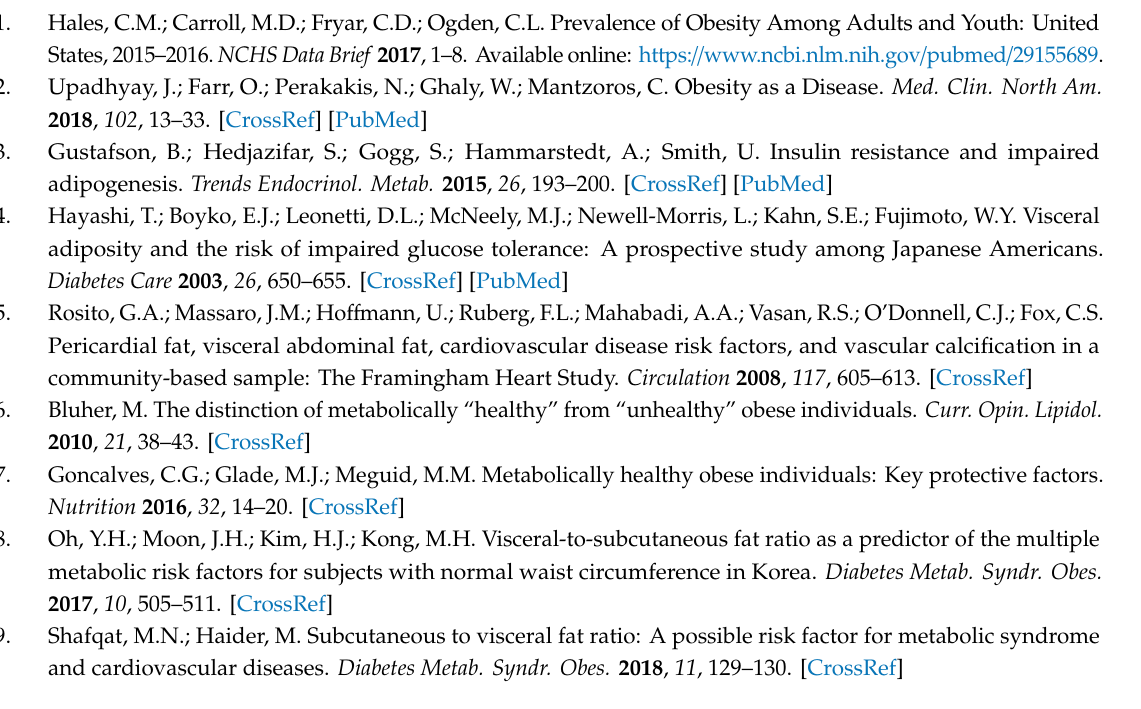
Figure S1: Analysis of housekeeping gene expression and adipose stem cell di ff erentiation. Average expression was calculated as genometric mean of three biological replicates, Figure S2: Bisulfite PCR analysis of NRG1 Type III CpG island. Bisulfite treatment causes cytosine (C, blue) to sequence as thymidine (T, green). Methylation is detected as retention of cytosine (blue traces) relative to T (green traces) on chromatograms (for clarity, G and A traces omitted). Note that 1 µ m DAC does not demethylate this locus. Arrows mark CpG sites where methylation can occur, Table S1: All genes significantly upregulated or downregulated by DAC in volcano